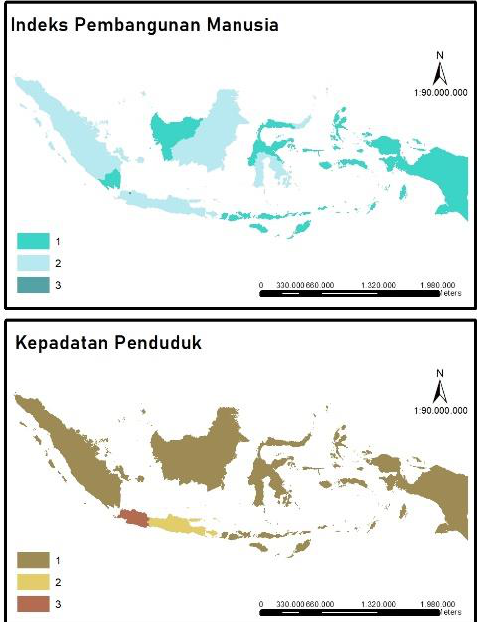
Figure 4 IPM Data Scoring and Population Density